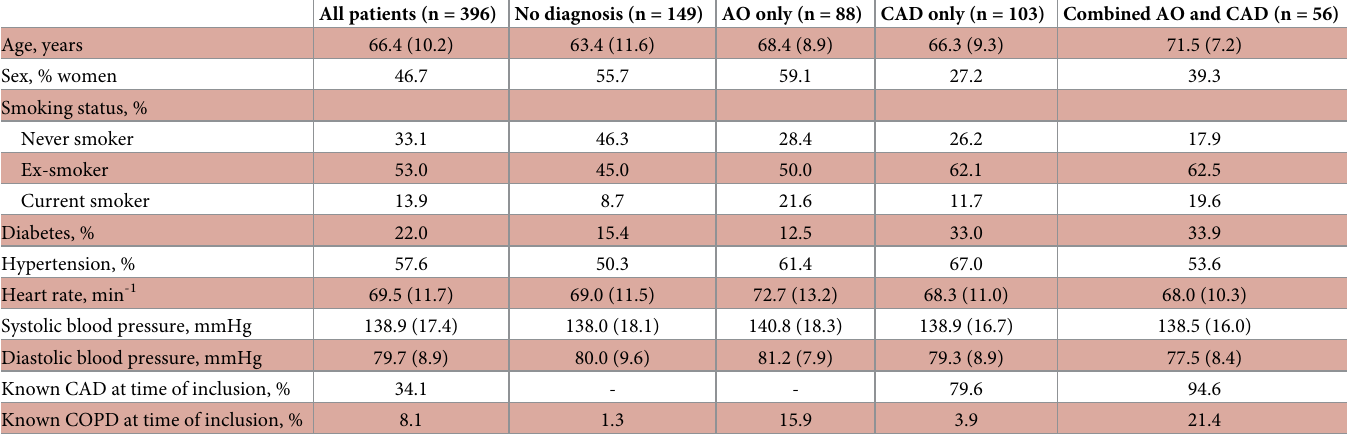
Table 1. Patient